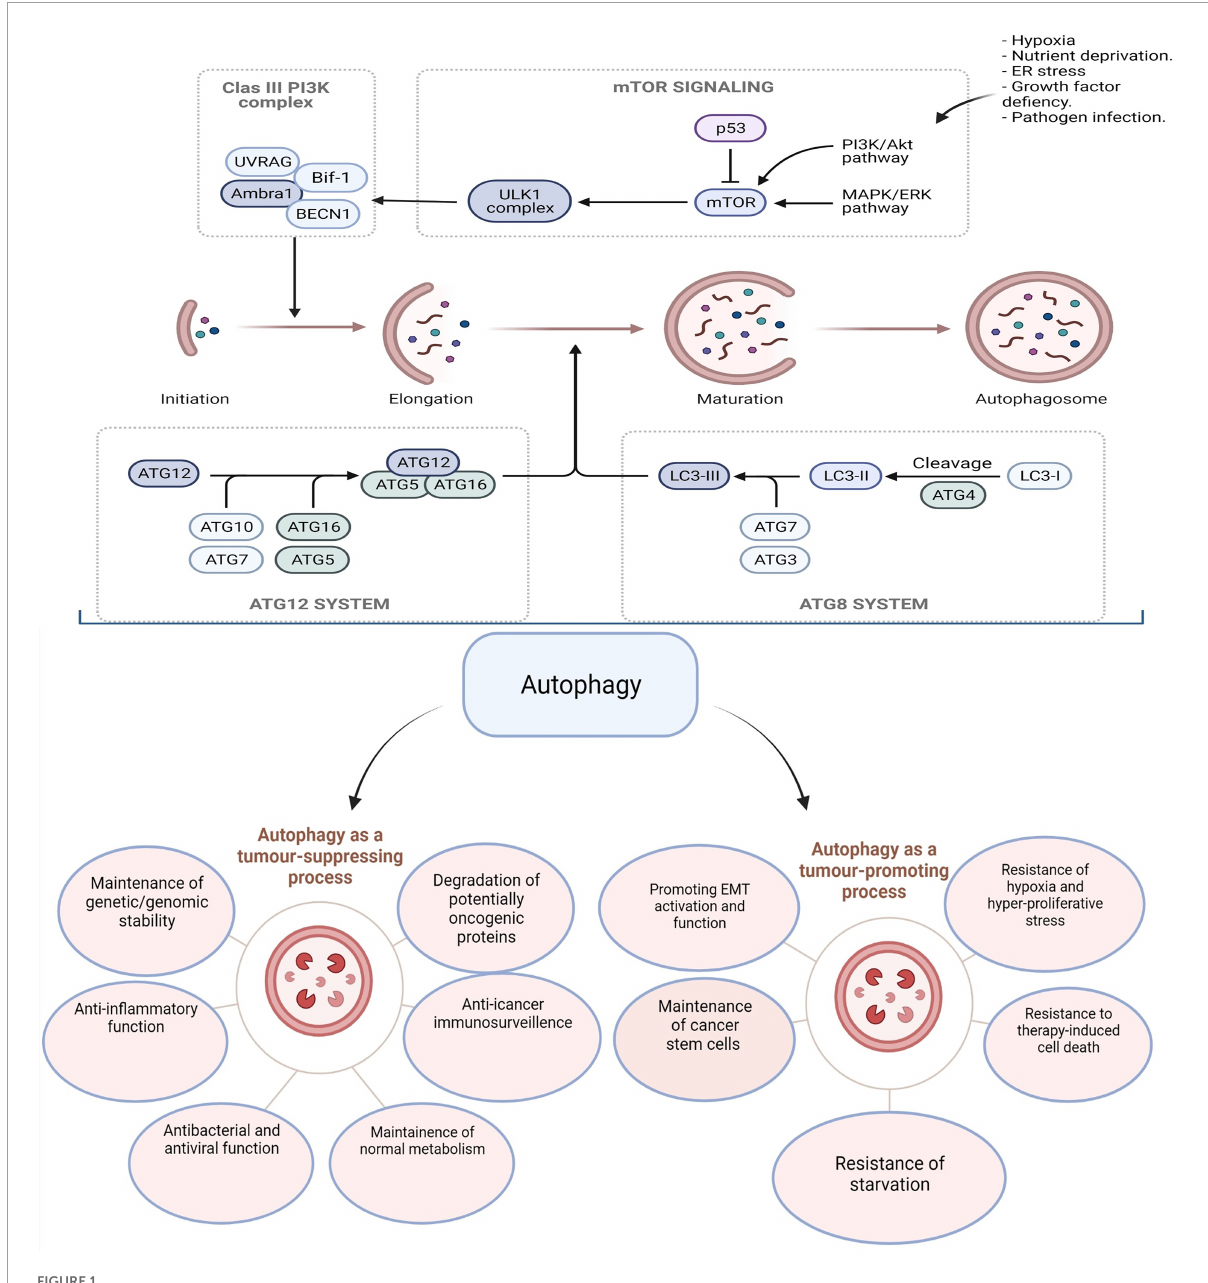
FIGURE1 Multiple steps are involved in autophagy machinery: induction, initiation, vesicular expansion, lysosomal fusion, and degradation. Autophagy has contradictory roles in tumorigenesis by either promoting or suppressing depending on the stage of cancer. The figure was modified from Burada et al.